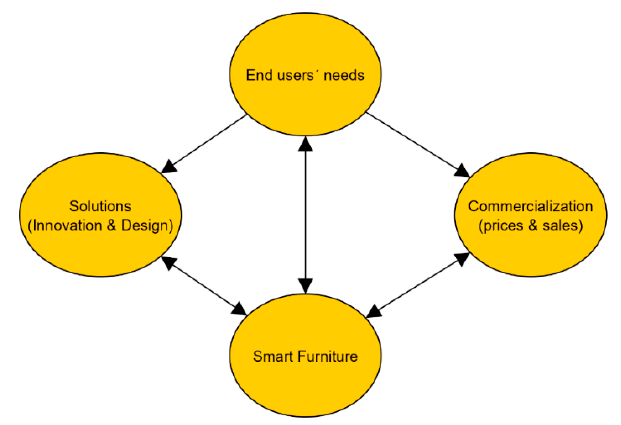
Figure 1. Conceptual framework for the study .